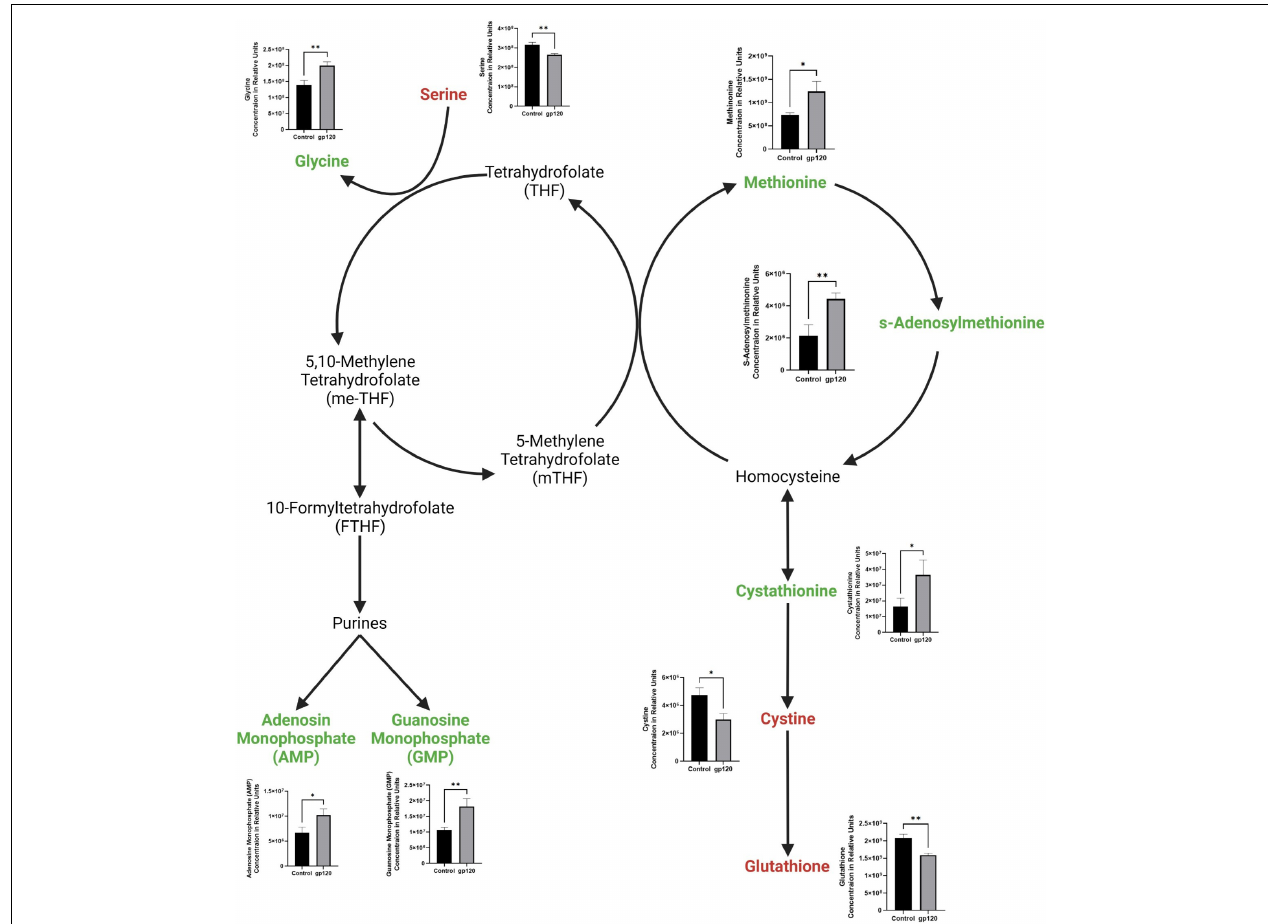
FIGURE 4 | Alterations in folate cycle and methionine cycle with gp120 treatment. Folate cycle and methionine cycle pathway with metabolites that are upregulated (green) and downregulated (red) in LUHMES treated with gp120 compared to control cells. Graphs show changes in folate and methionine cycle metabolites, as well